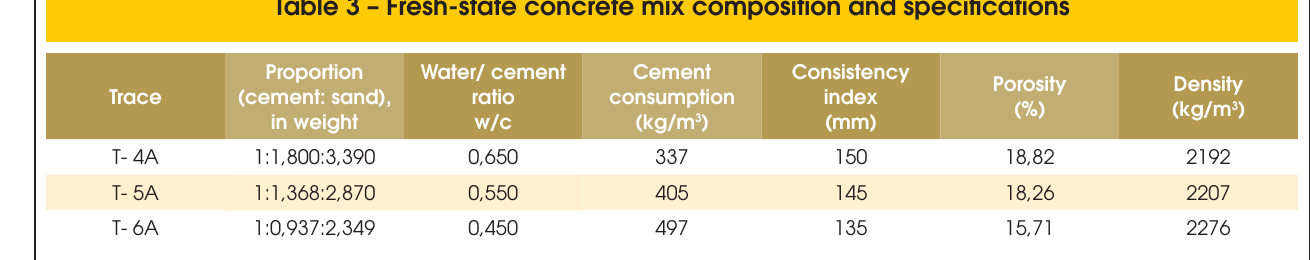
Table 3 – Fresh-state concrete mix composition and